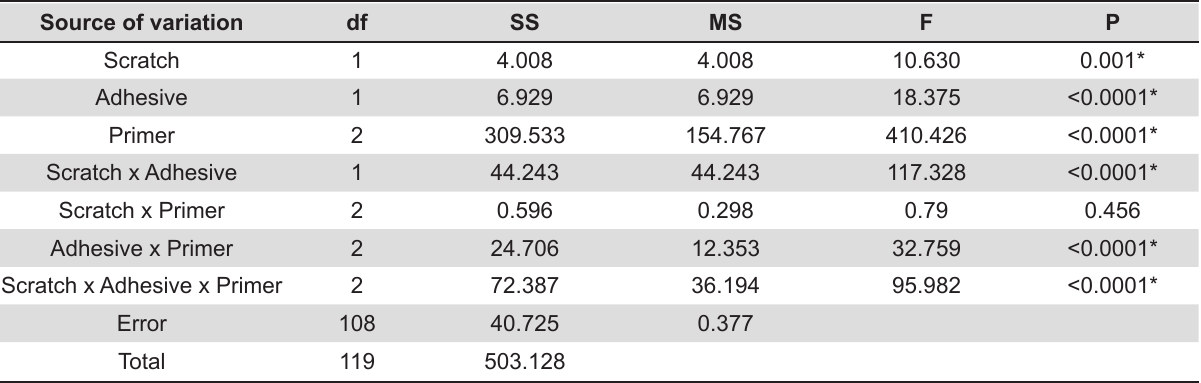
Scratch x Primer Scratch x Adhesive x Primer